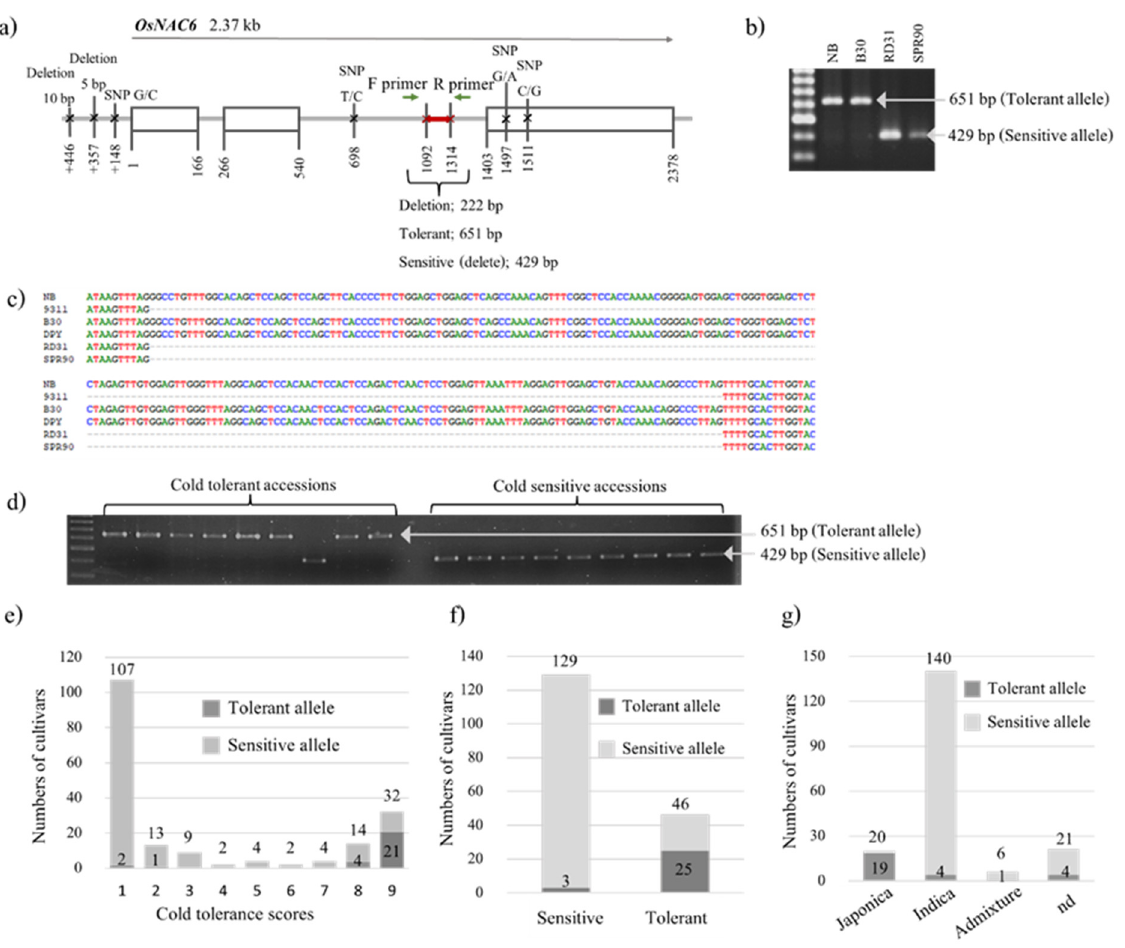
Figure 2. Mutation in NAC6 and its marker used for genotyping . ( a ) Structure of NAC6 showing polymorphic sequences between japonica (Nipponbare) and indica (9311) . ( b ) Validation of the genotypic assay for two cold-tolerant (NB and B30) and two cold-sensitive (RD31 and SPR90) reference cultivars . ( c ) Sequence alignment of amplicons from cold-tolerant (NB, DPY, and B30) and cold-sensitive (RD31 and SPR90) reference cultivars . ( d ) Representative examples of genotyping ten cultivars scored as cold-sensitive and ten cultivars scored as cold-tolerant among 187 accessions . ( e ) Allele frequency of NAC6 distributed in 1–9 cold tolerant scores of 187 rice accessions . ( f ) Allele frequency of NAC6 in extremely tolerant (score 8,9) and extremely sensitive (score 1–3) rice accessions . ( g ) The distribution of tolerant and sensitive alleles of NAC6 in each subspecies group .